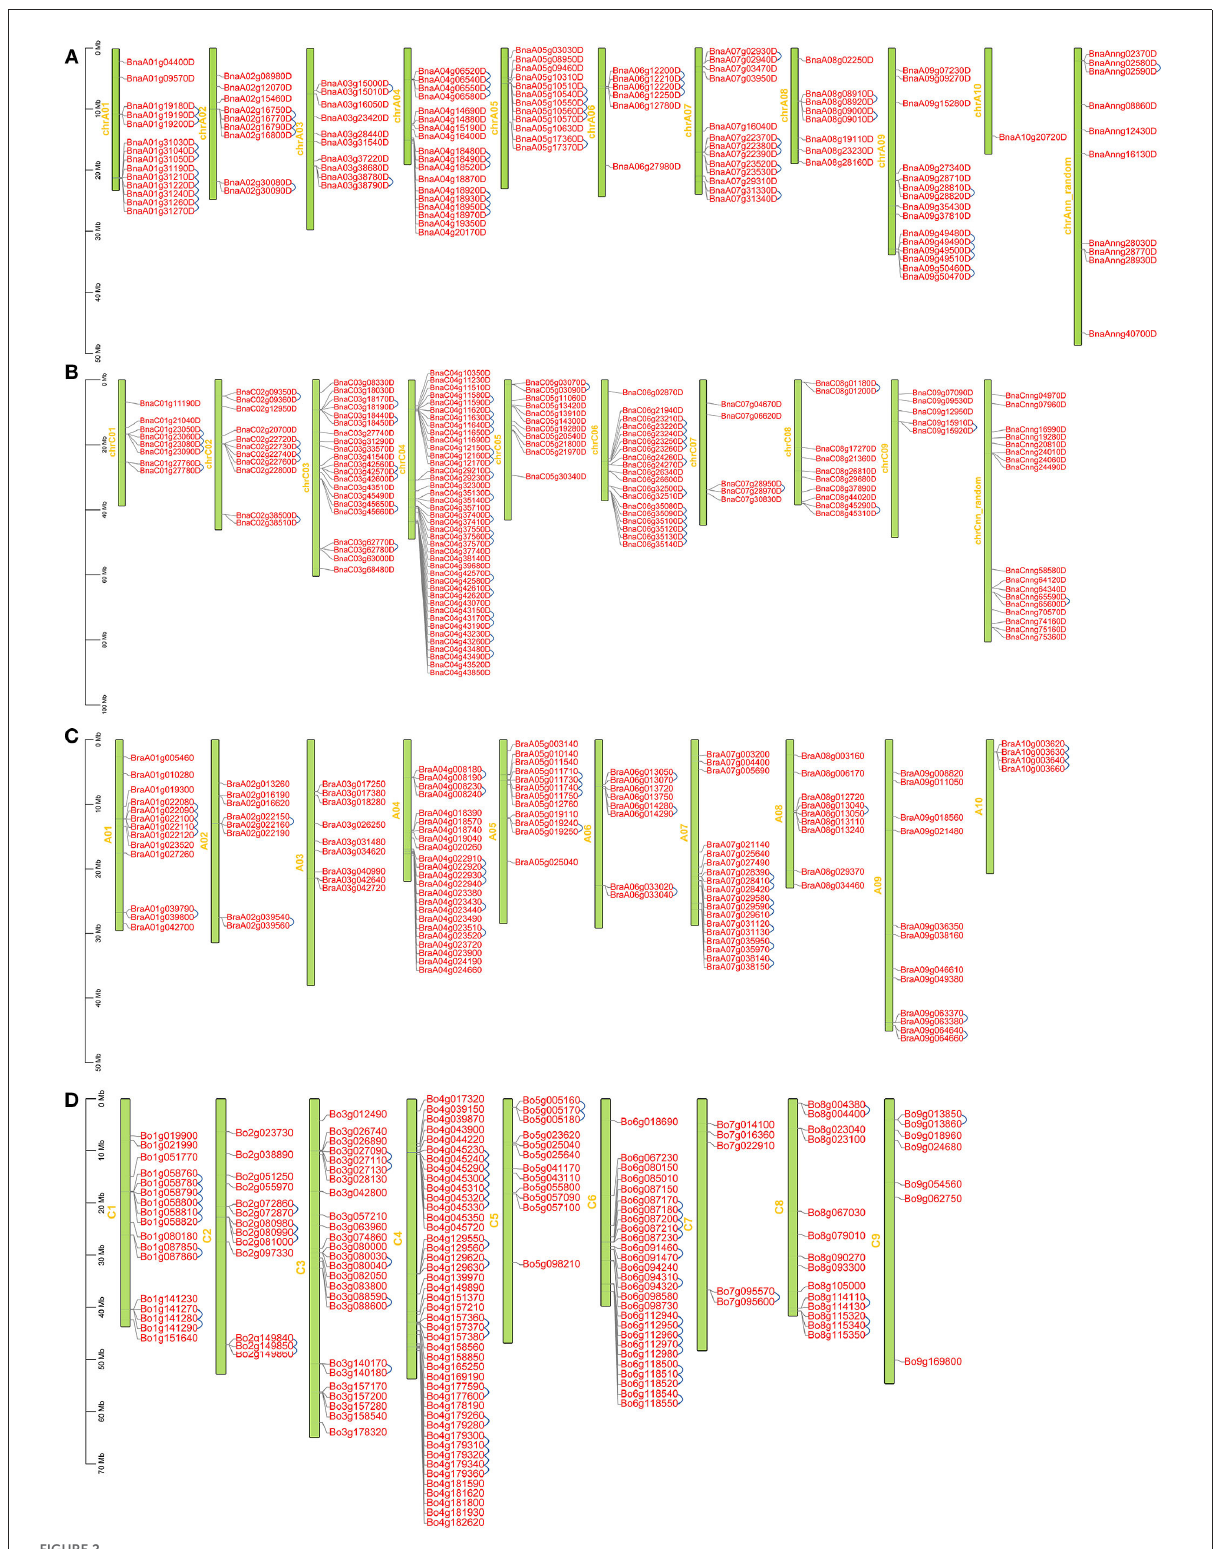
FIGURE2 Locations of RLP genes on chromosomes in Brassica napus , Brassica rapa and Brassica oleracea . (A, B) Locations of RLP genes on chromosomes in B. napus ; (C) Locations of RLP genes on chromosomes in B. rapa . (D) Locations of RLP genes on chromosomes in B. oleracea . A01-A09, C01-C08, and chrA01-chrC09 represent the chromosome number in B. rapa , B. oleracea, and B. napus , respectively. The blue line represents tandem